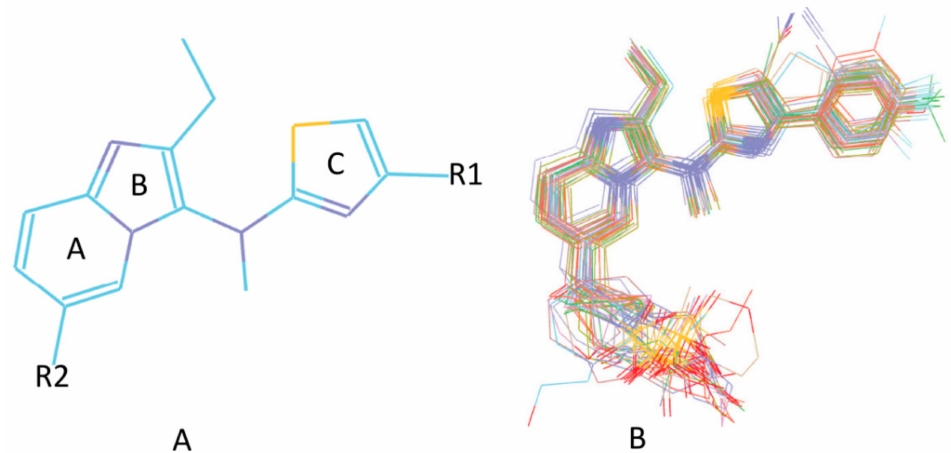
Figure 5. ( A ) The sca ff old of 31 autotaxin inhibitors. ( B ) The alignment result of 31 Mcl-1 inhibitors based on the poses acquired by the docking study calculation.